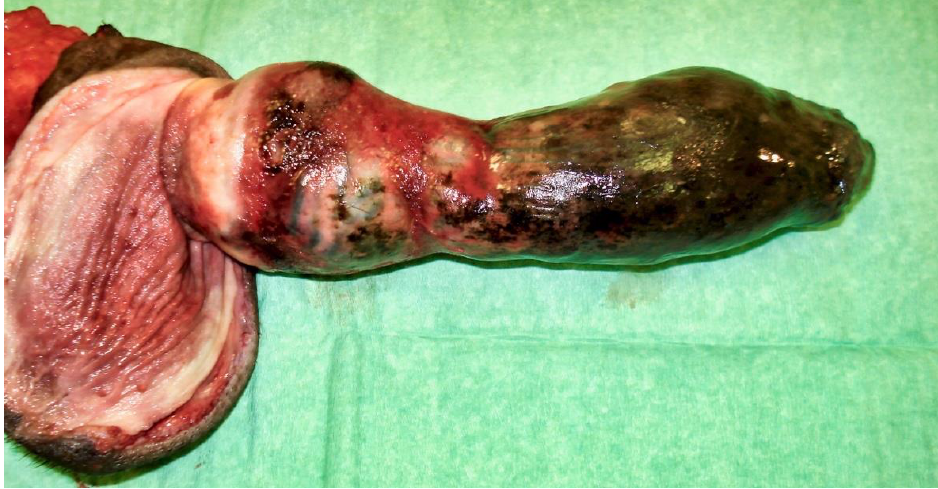
Figure 7. Resected specimen showing a more marked necrosis at the tip of the penis.